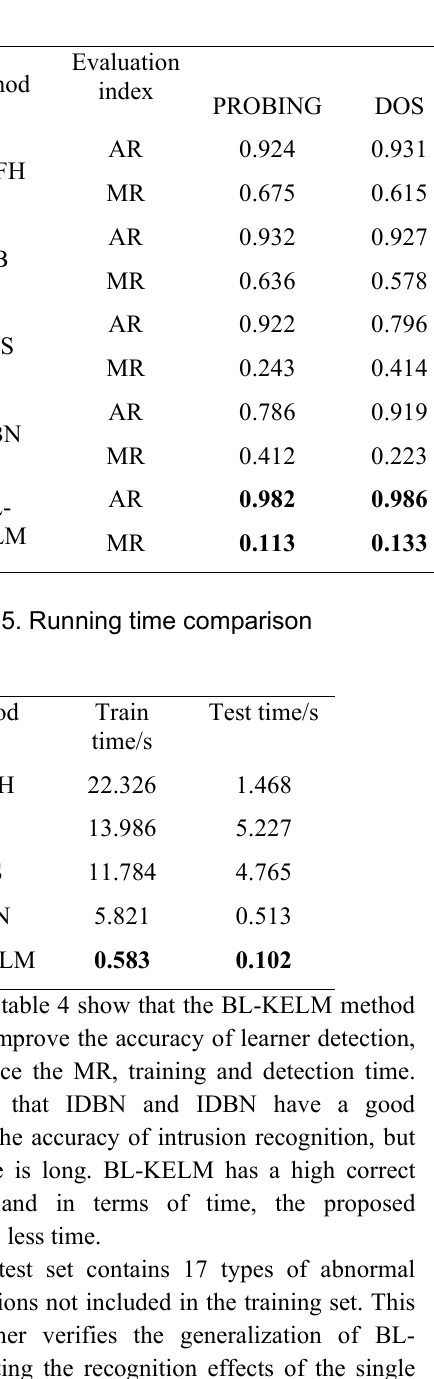
Table 4. Comparison results